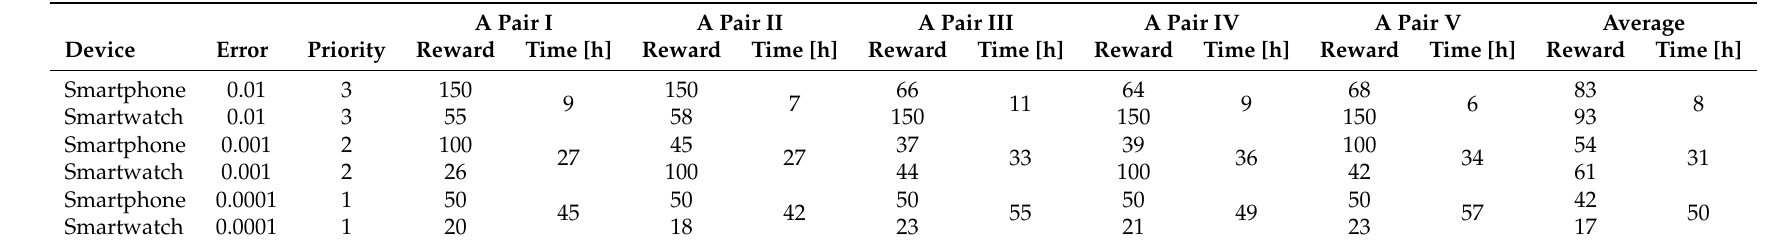
Table 2. Obtained results for a network composed of 3 hidden layers.